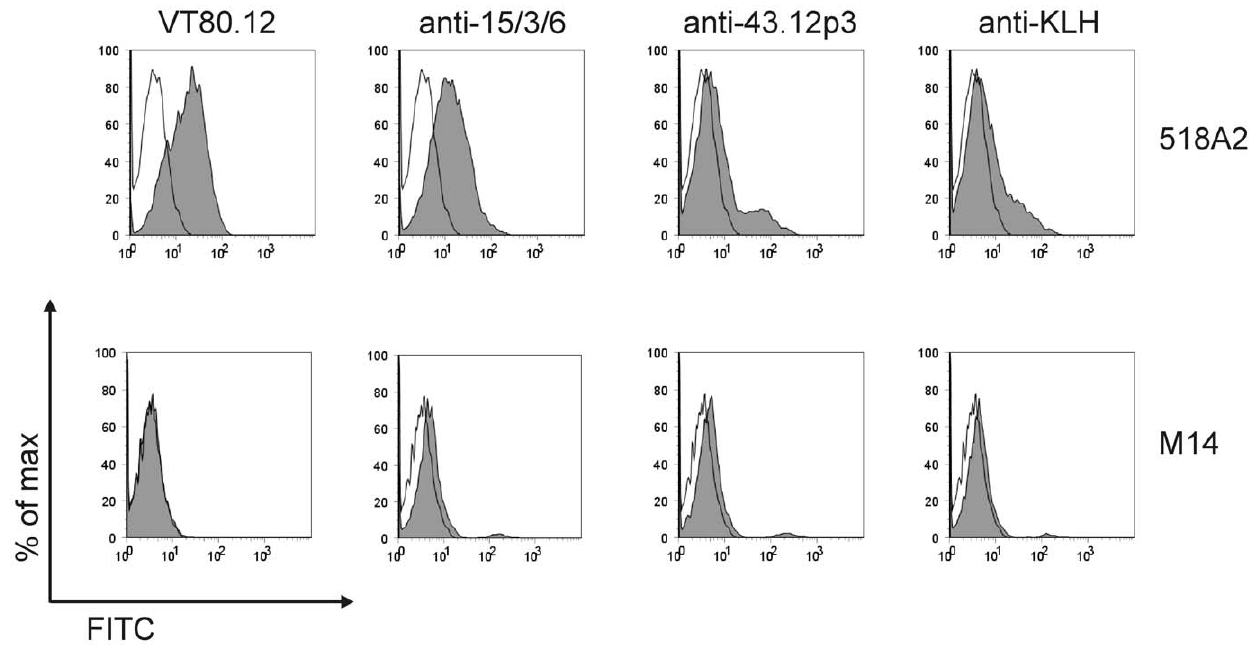
Figure 5. HMW-MAA-specific immune response of immunized BALB/c mice. Human melanoma cell lines 518A2 and M14 were either incubated with 1 m g mAb VT80.12 (as positive control) or a 1:10 dilution of pooled mouse sera of each group. Bound IgG were detected with FITC- labeled goat anti-mouse IgG. Histogram overlays show unstained (white) and stained cells (grey).